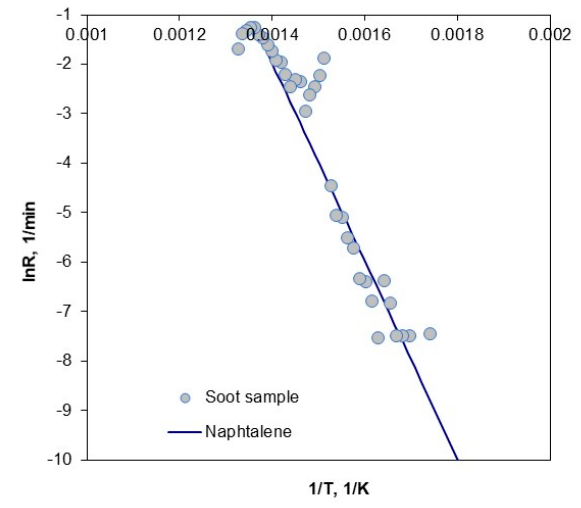
Figure 11. Arrhenius plots for combustion of the soot sample in TGA, compared with Arrhenius plots of combustion of naphthalene from computational experiments.